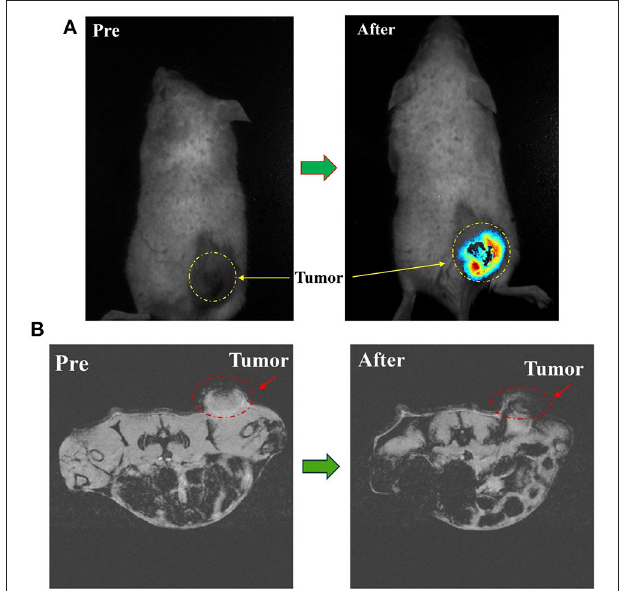
FIGURE 5 | (A) In vivo NIRF imaging of tumor mice before and 8h after tail vein injection of PTX-Herceptin-MNPs-Fe 3 O 4 . The yellow dashed circles indicate the tumor. (B) T*2-Weighted MR images of the mice tumor before and 8h after tail vein injection of PTX-Herceptin-MNPs-Fe 3 O 4 using a 7T MR scanner. The red dotted circles displayed the tumor site.